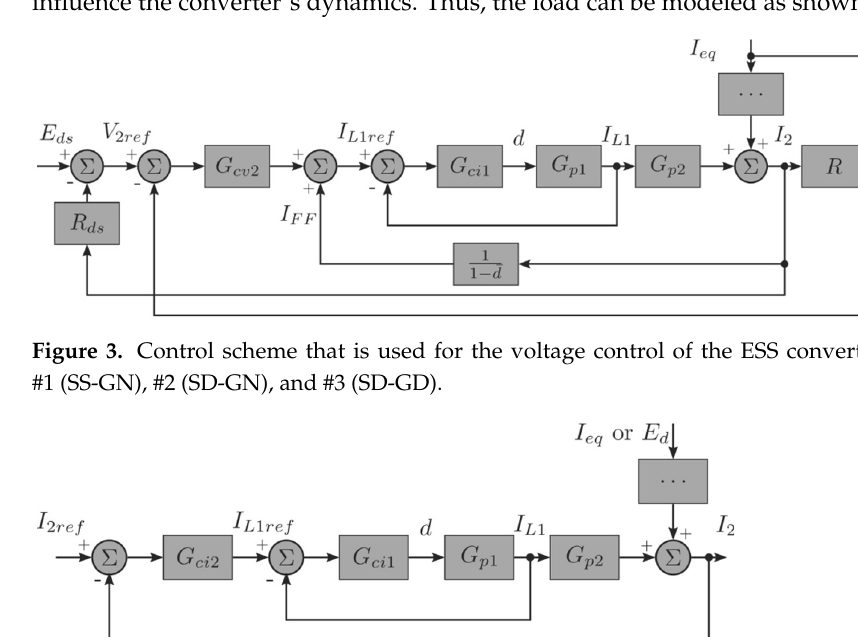
Figure 3. Control scheme that is used for the voltage control of the ESS converter in scenarios #1 (SS-GN), #2 (SD-GN), and #3 (SD-GD).